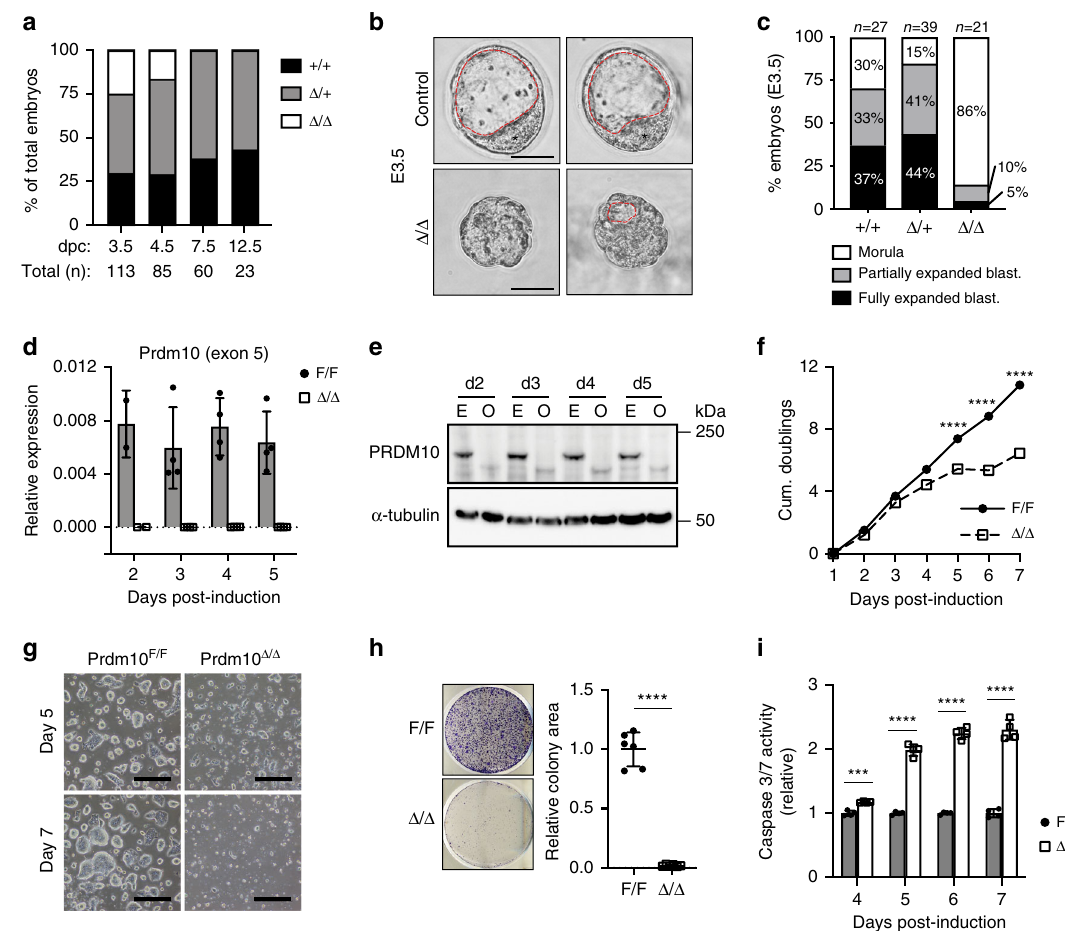
Fig. 1 Prdm10 is essential for mouse preimplantation embryogenesis and mESC growth. a Frequency of embryo genotypes obtained from heterozygous intercrosses at each developmental stage. E3.5 embryos are recovered at the expected Mendelian distribution; no Prdm10 Δ / Δ embryos are observed by E7.5. b Representative images of mutant ( Prdm10 Δ / Δ ) and control ( Prdm10 + / + , Prdm10 Δ / + ) embryos isolated at E3.5. The inner cell mass (ICM) is labeled with an asterisk, and the blastocoel is de fi ned by a red dashed line. Scale bar: 50 μ m. c Scoring of E3.5 embryos into three phenotypic categories: morula, partially expanded blastocyst, or fully expanded/cavitated blastocyst. n = 27 ( Prdm10 + / + ), n = 39 ( Prdm10 Δ / + ), n = 21 ( Prdm10 Δ / Δ ). d qRT-PCR analysis of Prdm10 exon 5 expression in OHT-treated Prdm10 F/F ; CreER T2 ( Δ / Δ ) mESCs compared with vehicle-treated (F/F) controls at indicated time-points post- induction. Expression normalized to Ubb ; n = 3 biological replicates. e Western blot analysis of PRDM10 protein levels in Prdm10 F/F ; CreER T2 mESCs at indicated time-points (days) after exposure to EtOH (E) or OHT (O). Loading control, α -tubulin. f PRDM10-depleted mESCs exhibit an increasingly severe cell growth defect over time. Cells were passaged at constant density every 2 days and counted daily up to Day 7 post-induction; n = 4 samples. Y -axis: cumulative population doublings. g Representative bright fi eld images of Prdm10 F/F and Prdm10 Δ / Δ mESC colonies at Day 5 and 7 post-induction. Cells were plated at equal densities 2 days prior to image acquisition. Scale bar: 500 μ m. h Representative images from colony formation assay; n = 6. Prdm10 F/F and Prdm10 Δ / Δ mESCs were seeded at Day 3 post-induction and fi xed for analysis at Day 8. i Caspase 3/7 activity in Prdm10 Δ / Δ mESCs relative to Prdm10 F/F controls, at Day 4 to 7 post-induction; n = 4 technical replicates for each time-point. Data are presented as mean ± s.d. Representative data shown